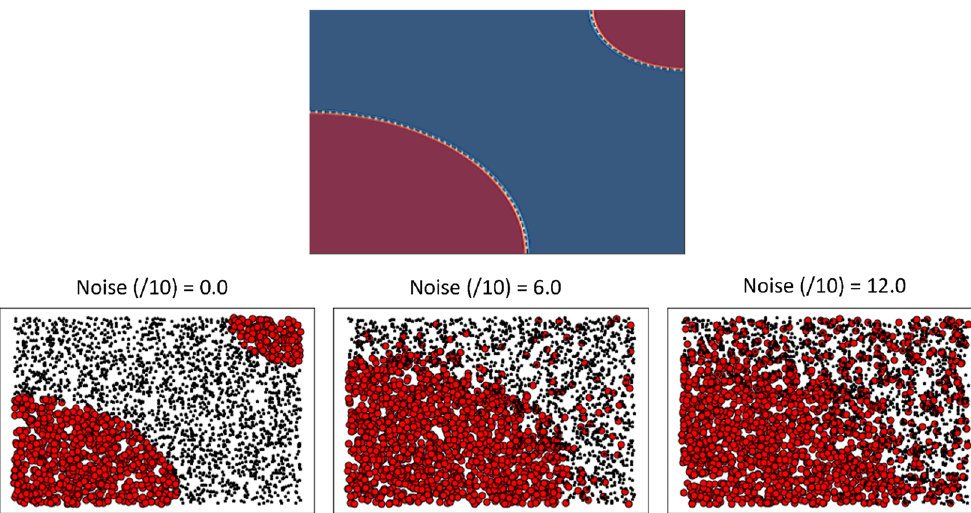
Figure 1. (First row) Pattern of Dataset. (Second row) Pattern of dataset for different noise levels.